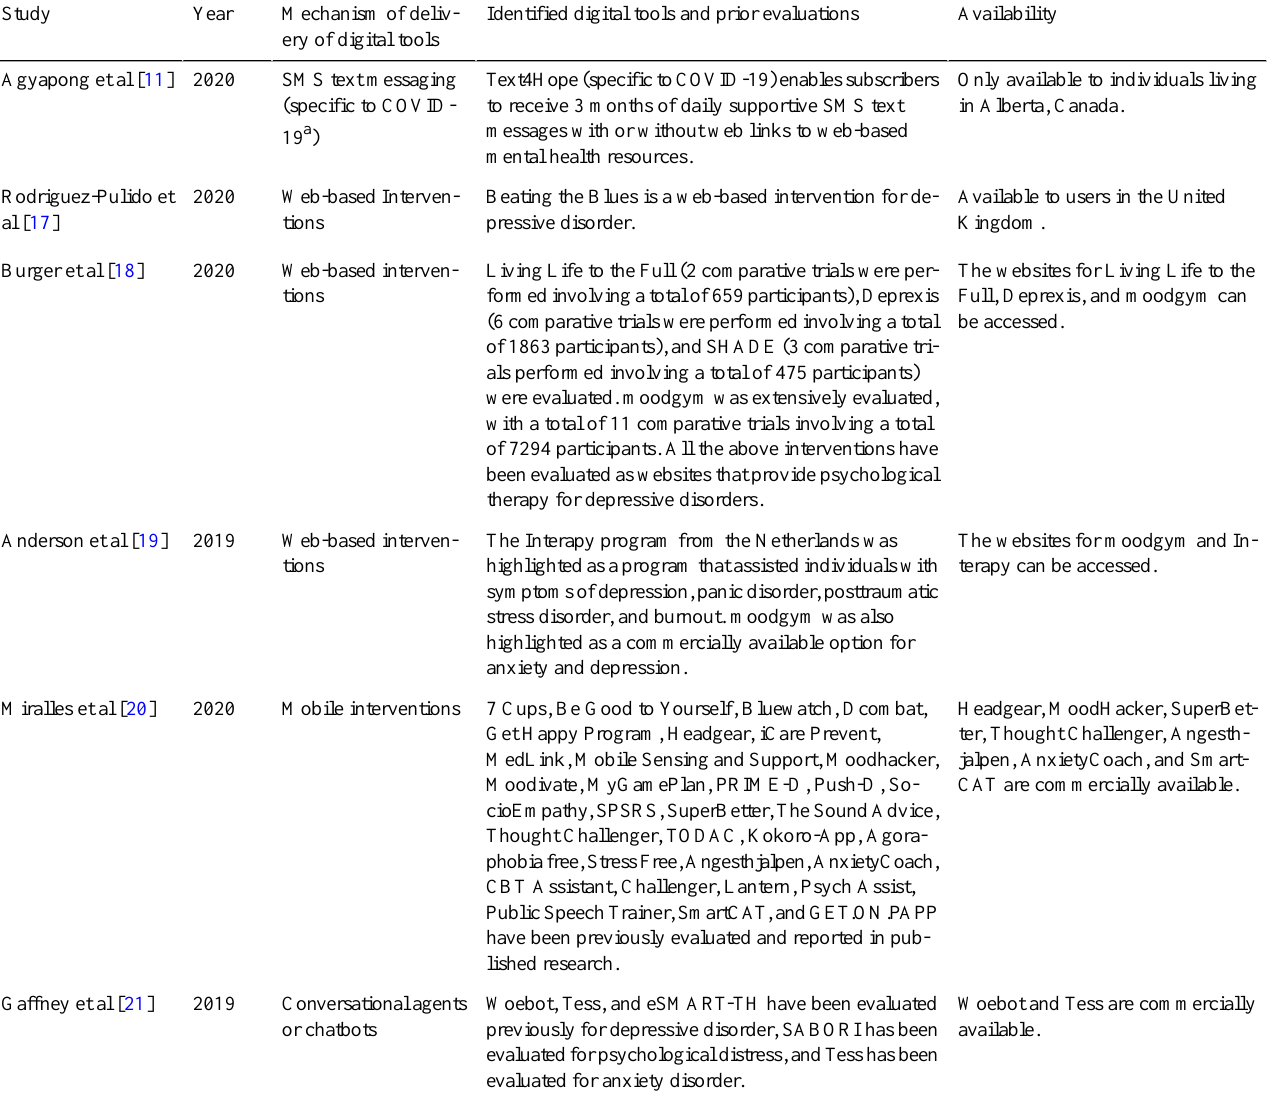
Table 1. Overview of the studies identified in the literature search.